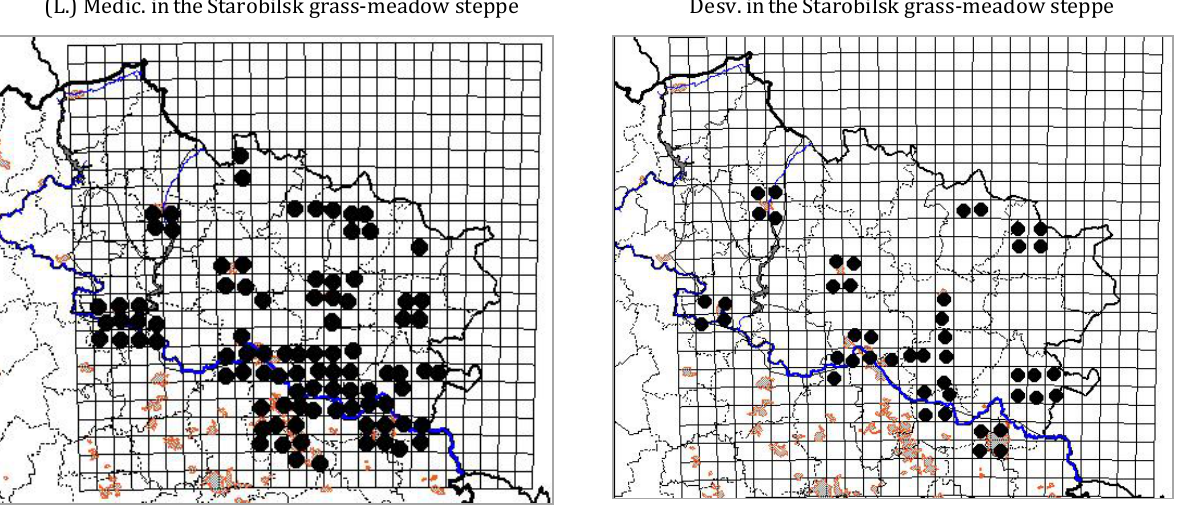
Fig. 12. The map of the distribution of Centaurea diffusa Lam. in the Starobilsk grass-meadow steppe